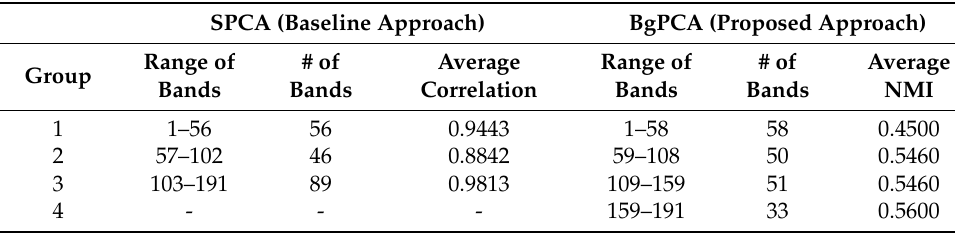
Table 2. Band grouping information of the Washington DC (HYDICE) HSI.